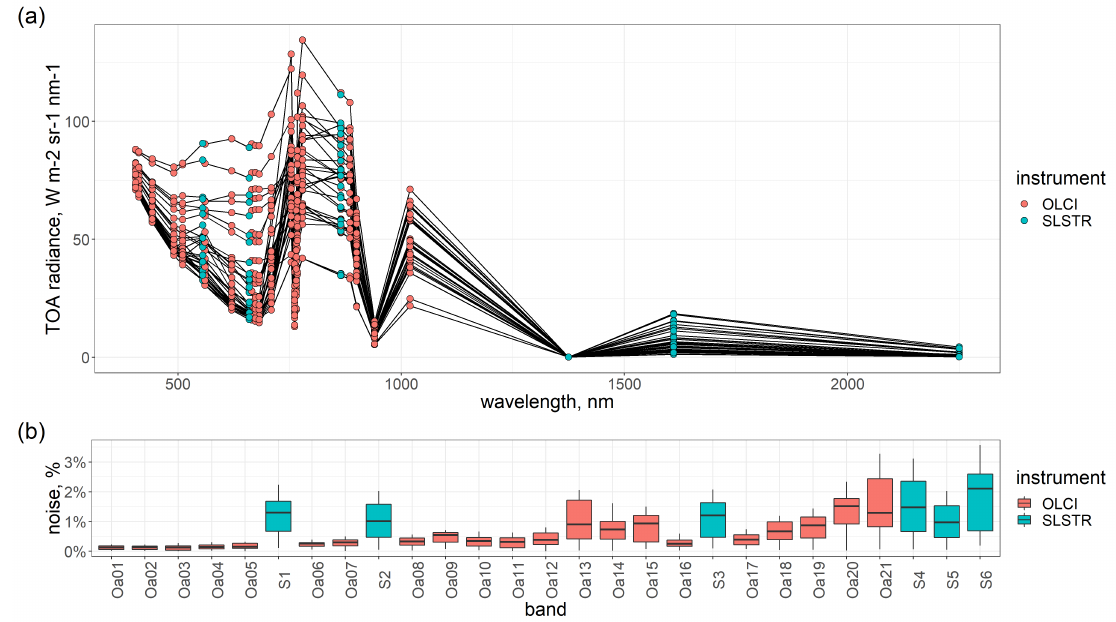
Figure 3. ( a )—33 simulated vegetation TOA reflected radiance spectra in bands of optical Sentinel-3 instruments (OLCI and SLSTR), ( b )—added noise based on signal-to-noise ratio of the